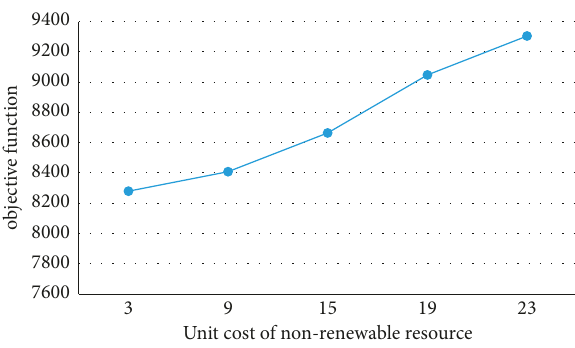
Figure 6: Amount of change in the objective function by increasing the unit cost of the nonrenewable resource.